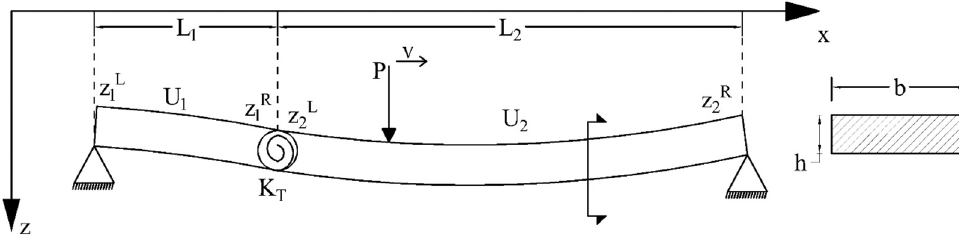
Figure 3. Simply supported beam with crack at station, L 1 modelled as a slope discontinuity by inserting a rotational spring K T .